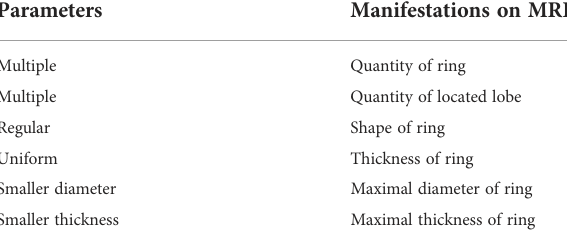
TABLE 5 Diagnostic criteria of E-GBM with MUT BRAF.